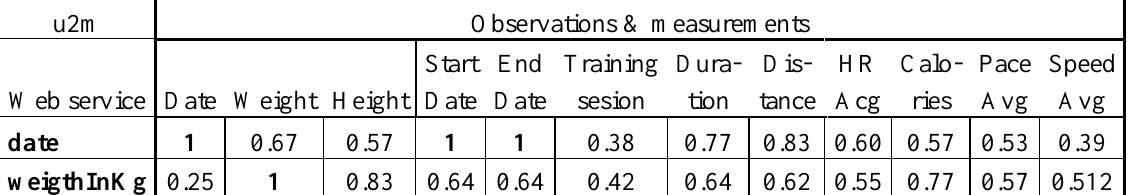
Table 9. Partial view of similarity matrix (Web service request concepts, ubiquitous user model concepts).